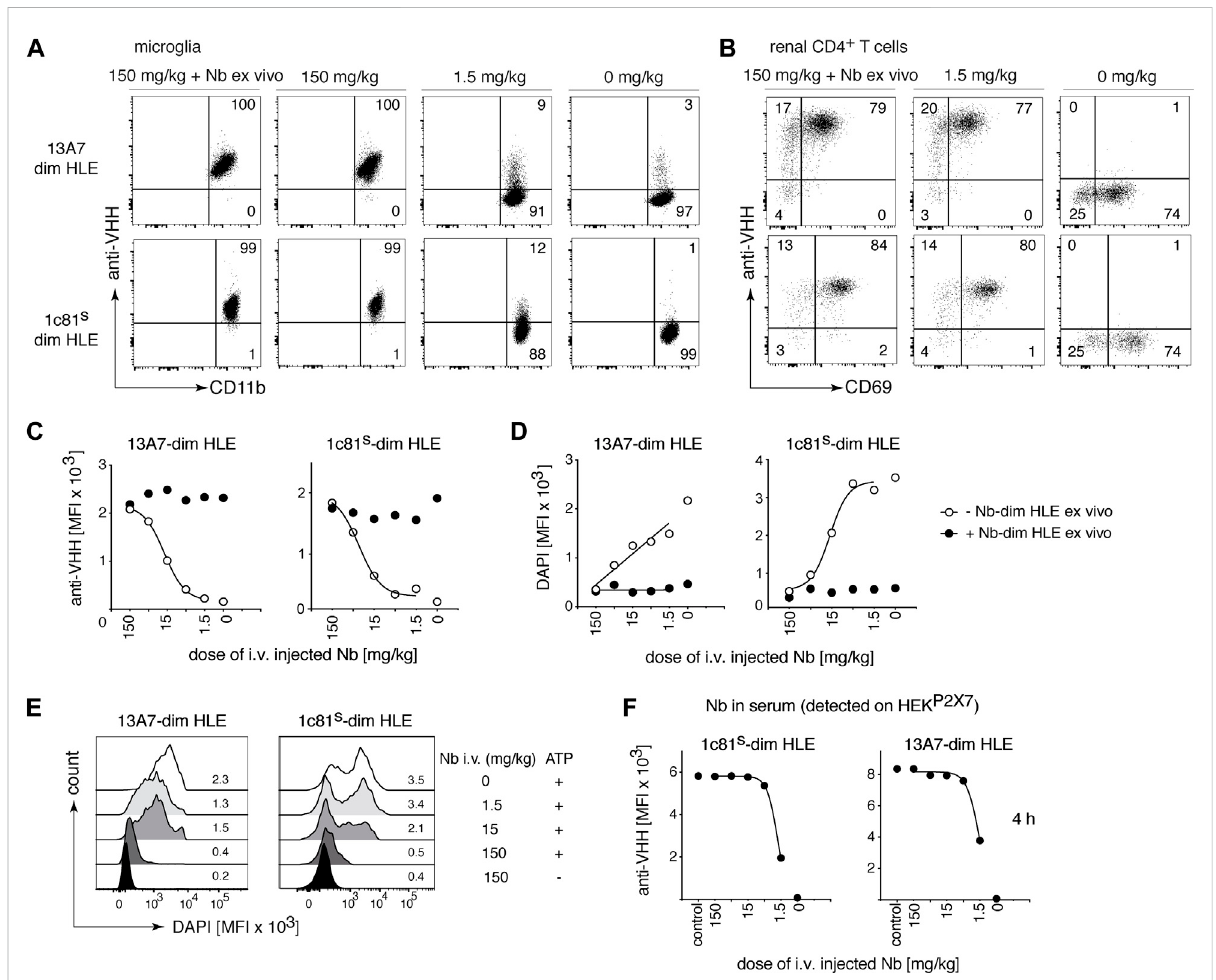
Full occupancy and full blockade of P2X7 on microglia is achieved by a high dose of intravenously injected P2X7 nanobodies. Titrated amounts of the indicated bivalent HLE nanobodies were injected i. v. and 4 h later the occupancy of P2X7 by the nanobody was analyzed on microglia and kidney-resident helper T cells (T RMs ), as described in Figure 2. Flow cytometry dot plots of microglia (A) or renal CD4 + T cells (B) illustrate the relative occupancy of P2X7 achieved by the indicated concentrations of i. v. injected nanobodies. The maximal target occupancy is depicted after ex vivo additionofasaturatingdoseofnanobodies(+Nb exvivo ). (C) Graphsdisplaythedose-dependentMFIofP2X7stainingonmicrogliaobtainedby i. v. injection of nanobodies (open circles); closed circles = maximal staining obtained after ex vivo addition of saturating nanobodies. (D) P2X7 function, as determined by the ATP-induced DAPI uptake by microglia, was assessed by fl ow cytometry in the absence (open circles) or presence (closed circles) of saturating nanobodies added ex vivo . Cells were treated with 0.5 mM ATP at 37 ° C for 5 min (E) MFI of DAPI is displayed here as overlaid histograms. (F) Circulating nanobodies were analyzed in the serum of injected mice. Serum (1:100) was incubated with HEK P2X7 and bound bivalent HLE-nanobodies were detected by anti-VHH mAb. Graphs illustrate the MFI of HEK P2X7 cells versus the dose of i. v. injected Nb-dim HLE. Data are representative of three (13A7-dim HLE) and fi ve (1c81 s -dim HLE) (A – C) , or three (13A7-dim HLE) and six (1c81 s -dim HLE) (D – F) independent experiments. Dot plots shown are from a single mouse. An independent experiment refers to an experiment with a single mouse per condition, in which all mice were analyzed on the same